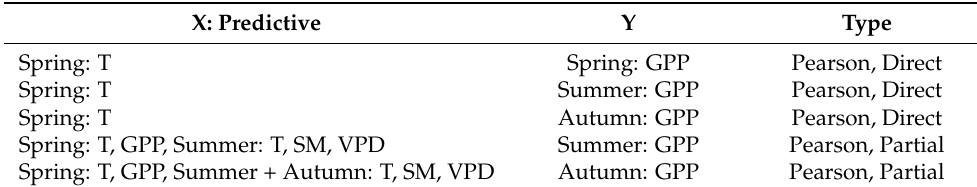
Table 3. Direct correlations between spring temperature and GPP anomalies, as well as two sets of variables (pertaining to summer and autumn GPP anomalies) were used in correlation analysis. All variables were converted into anomalies based on Equation (1) before Pearson’s correlations were performed.